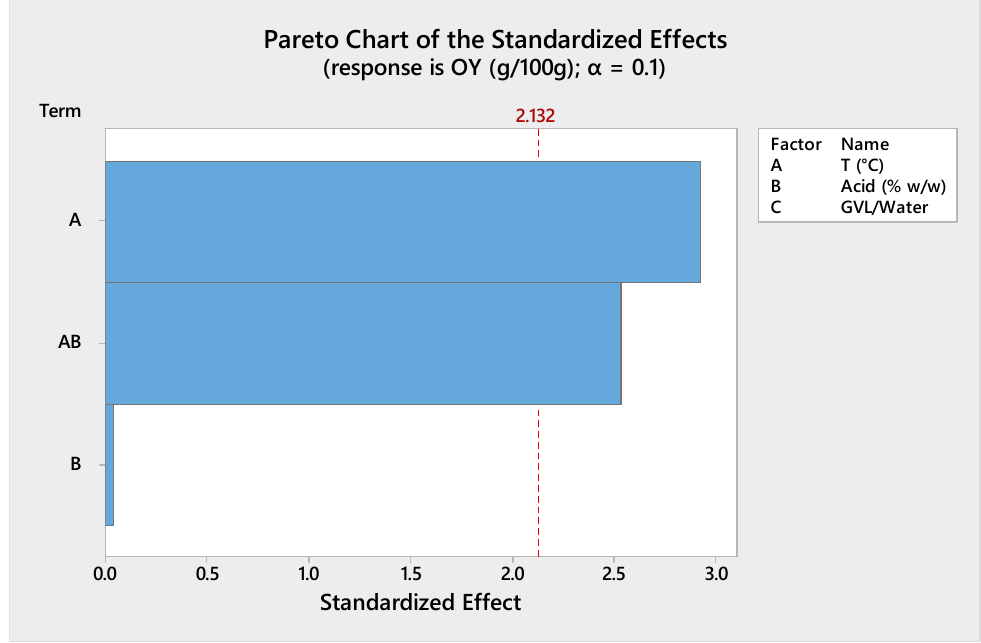
Figure 2. Pareto chart for the OY response, the dashed line indicates the significance limit of the factors on the response.